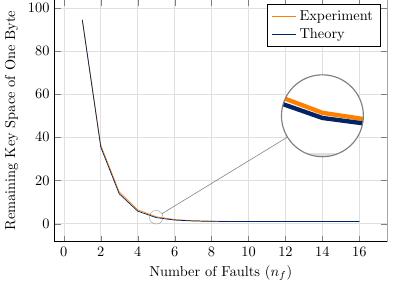
Figure 4: The number of required ciphertexts for the size of key search space to be one